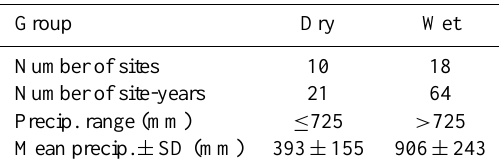
Table 2. Precipitation groups defined by a partition into “dry” and “wet” sites that optimises the flux variance explained by a piecewise-constant model of the effect of differences in total annual rainfall amount across all 28